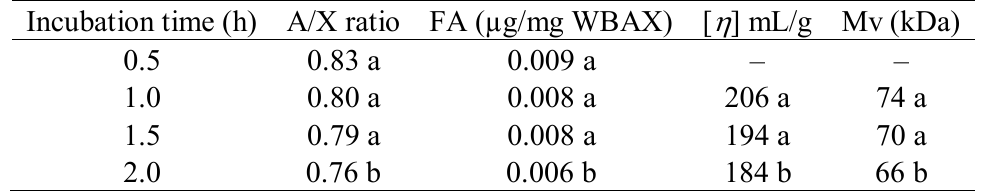
Table 1. Physico–chemical characteristics of wheat bran ferulated arabinoxylans (WBAX) extracted wth different incubation